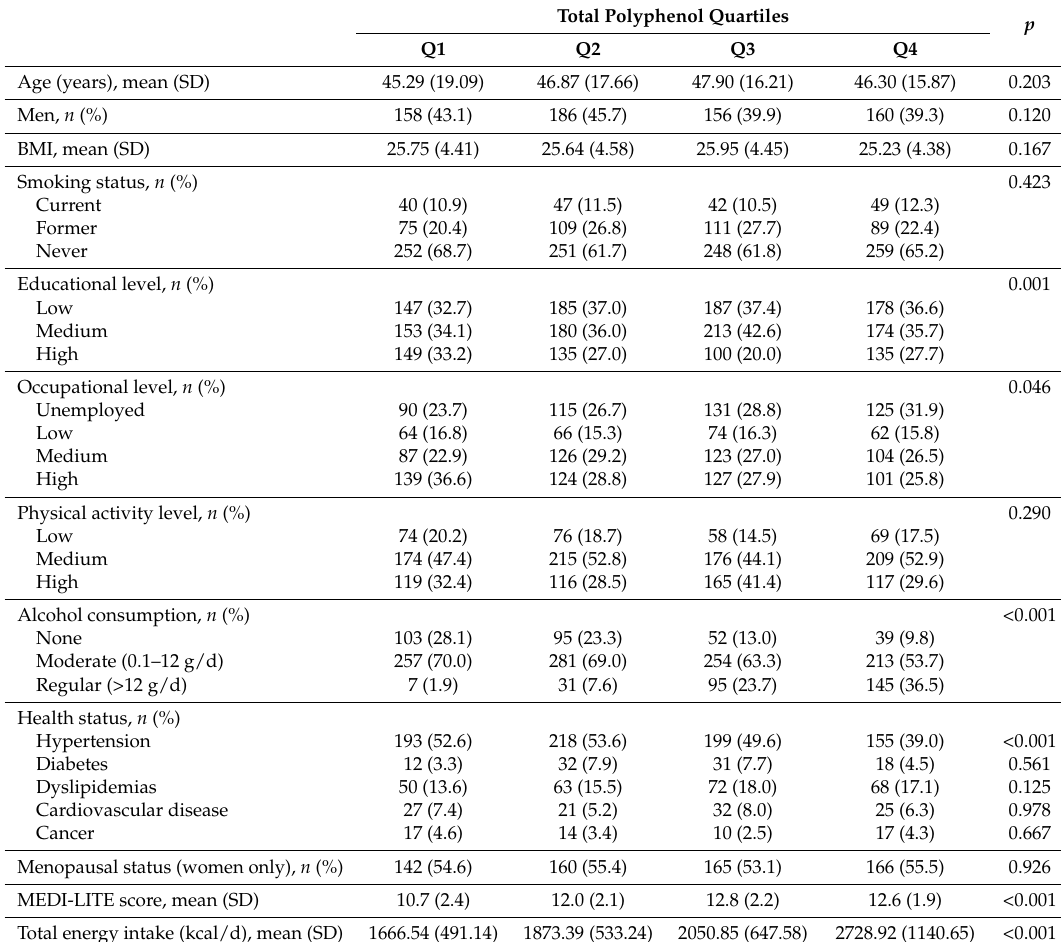
Table 1. Background characteristics of participants in the MEAL cohort by quartiles of total polyphenol intake